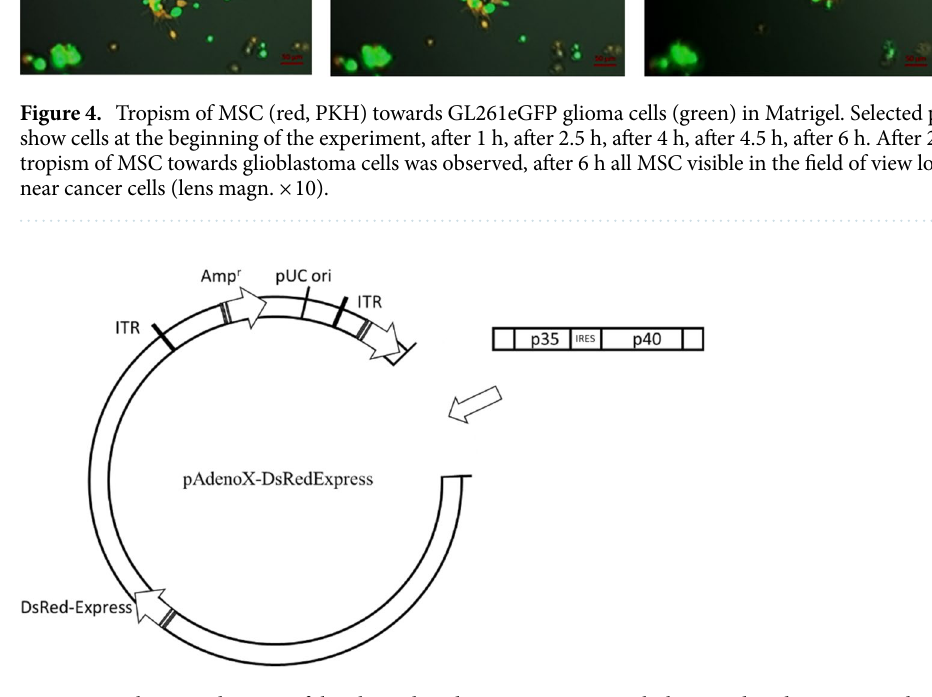
tors affecting tumor progression: vascularization and immune cells activation, the blood vessel network density and ratio of M1 and M2 macrophages in the tumors of treated and untreated mice were compared. Single, intratumoral administration of MSC/IL‑12 cells resulted in a significant reduction in vascular density in melanoma tumors. MSC/IL-12 were administered intratumorally 8 days after the inoculation with B16-F10 cells. Three and eight days after the administration the tumors were collected, fixed and the vascular density was investigated by immunohistochemistry. The vascular surface area (per 1 mm 2 of the preparation) in group that